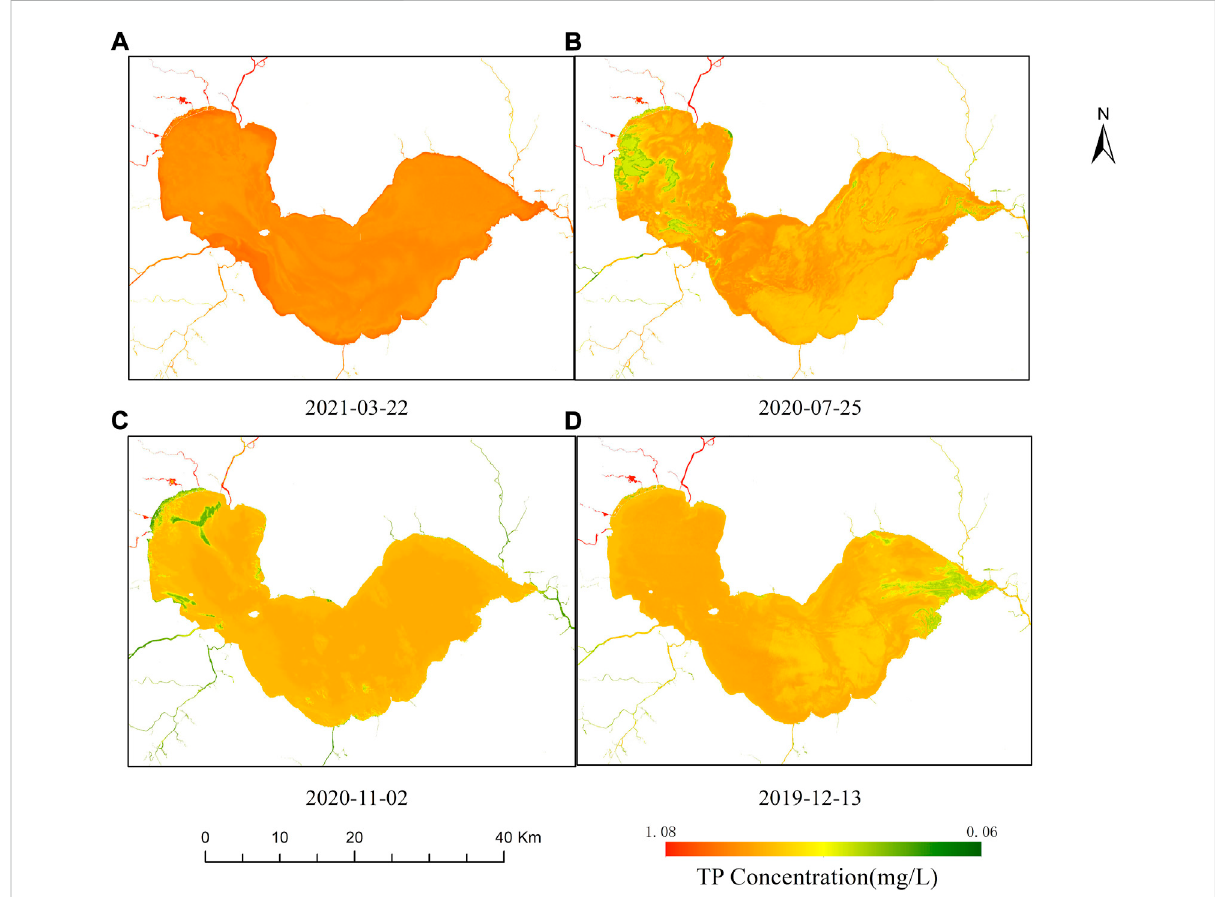
FIGURE 6 Remote-sensing retrieval results of the TP concentrations in the water around Chaohu Lake. (A) Total phosphorus distribution on March 22, 2021 (B) TotalphosphorusdistributiononJuly25,2020 (C) TotalphosphorusdistributiononNovember2,2020 (D) Totalphosphorusdistributionon December 13,